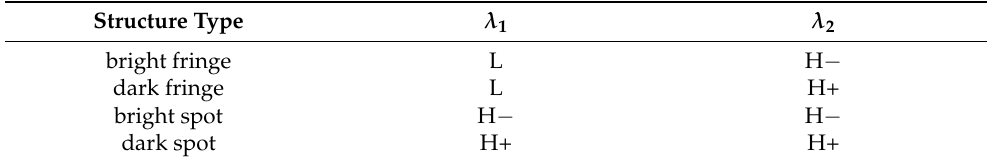
Figure 5. Schematic diagram of the eigenvectors and norm of the Hessian matrix (The curve structure is signal, and the point structure is noise.). Table 1. The relationship between the eigenvalues and the structure types (“L” means close to 0(|L| < 10 − 4 ), “H − ” means a large negative value(H − > 0.1), and “H+” means a large positive value(H+ > 0.1)). The value range of the eigenvalues is calculated according to the experimental spectra.